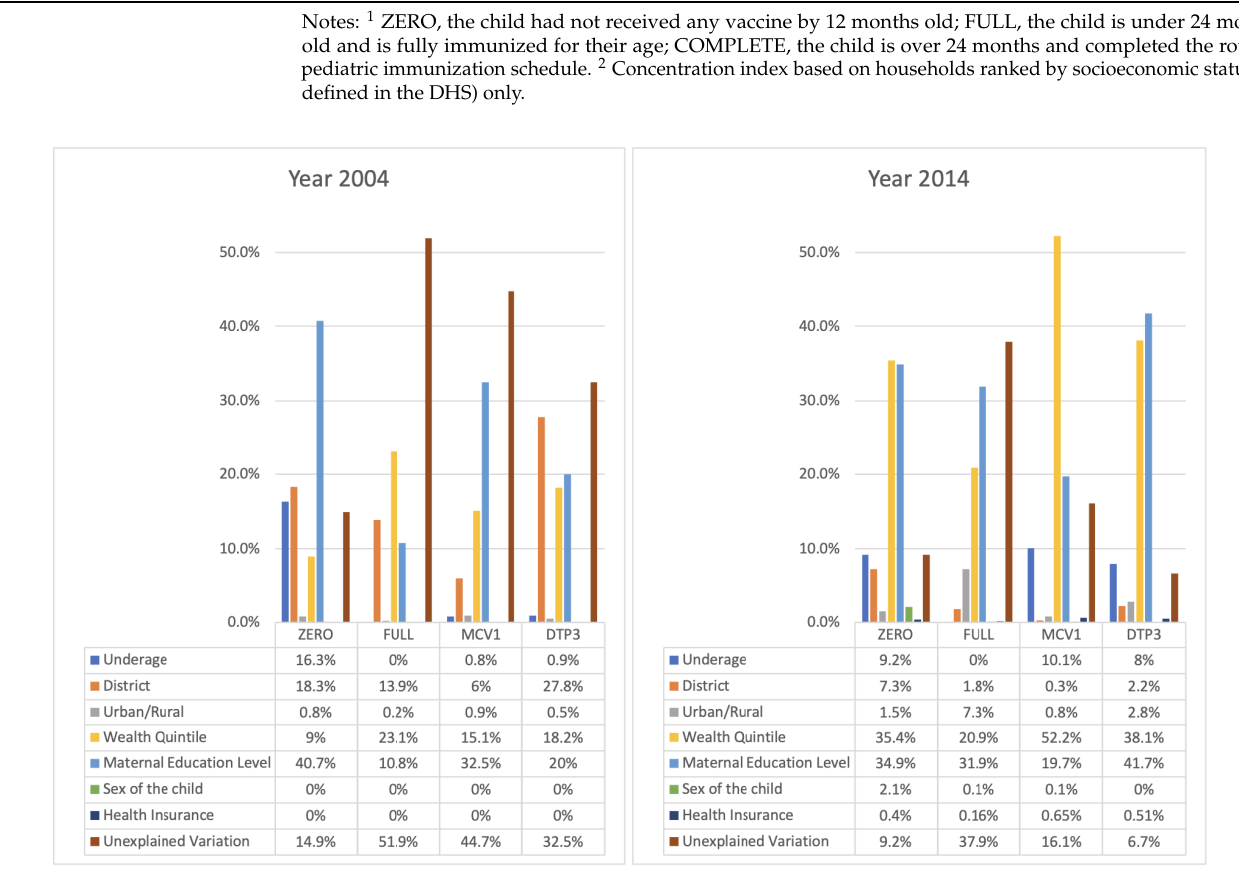
Figure 1. Share of variation in ZERO, FULL, MCV1, and DTP3 statuses associated with fair and unfair drivers for DHS year 2004 (left) and 2014 (right).